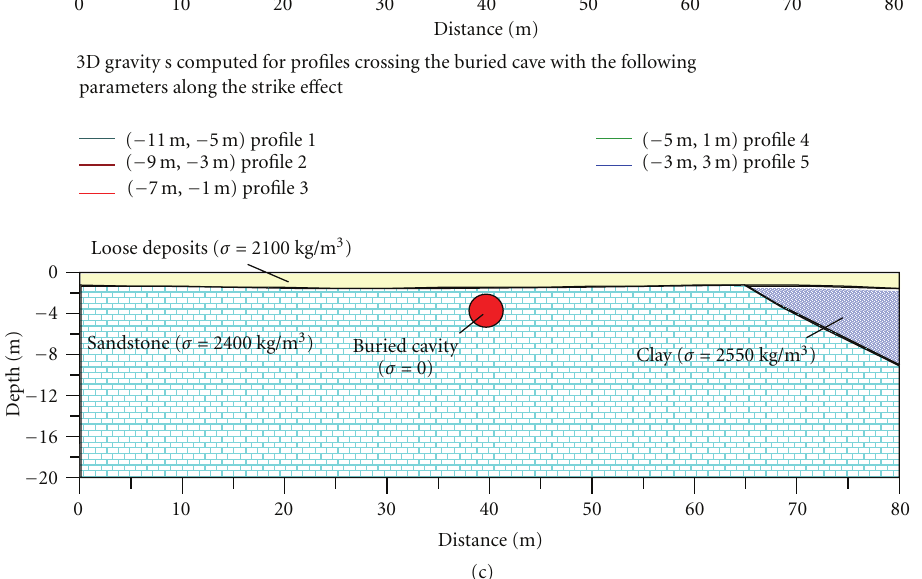
field conditions (registered anomaly is oscillating about